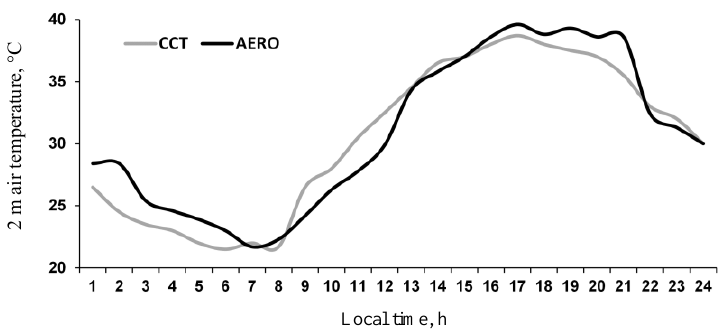
Fig. 2. Composites anomalies of: a) 1000 hPa temperature; b) outgoing longwave radiation at the top of the atmosphere, for 8 January 2012 and the climatological mean of the 1981 − 2010 interval. Figure built from images provided by the Earth System Research Laboratory of the National Oceanic and Atmospheric Administration, Boulder, Colorado, on its website [72]. In turn, Fig. 3 shows the air temperature at 2 m for the same day, recorded at the surface meteorological station of the Argentine Council of Scientific and Technical Research − Mendoza (CCT) (32  53' S, 68  52' W) and Mendoza International Airport (AERO) (32  50' S, 68  48' W). According to the image, the 2 m air temperature on that day at both stations reached its minimum value (21 − 22  C) around 8:00 LT. After 9:00 LT, it started to rise until 20:00 LT, when it started to drop again. Therefore, the meteorological intervention of injecting tropospheric SO 4 2 − aerosols took place between 9:00 and 20:00 LT.